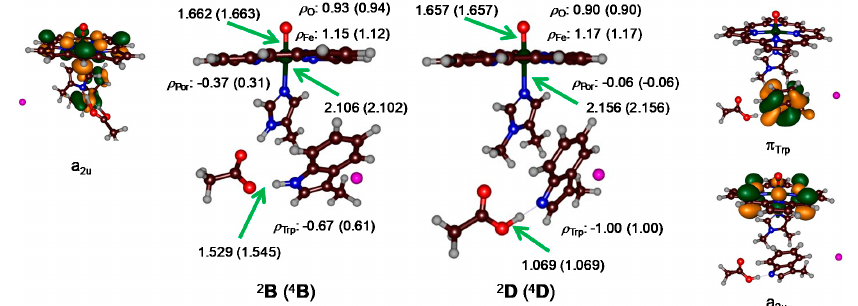
Figure 2. Optimized geometries of Compound I of C c P and N δ -methyl histidine engineered C c P as obtained with models B and D . Bond lengths are in angstroms and group spin densities in au. Singly occupied protein orbitals are given on the side. Quartet spin data in parenthesis.